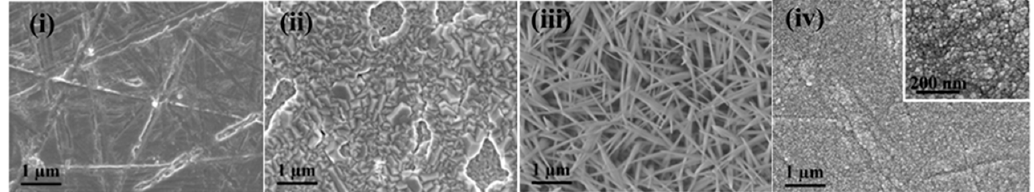
Figure 3. Performance of the IrO x /SrIrO 3 catalyst: ( A ) Chronopotentiometry measurements of 60 and 100 nm electrocatalysts, respectively, at a potential required to reach 10 mA/cm 2 per geometric area, for 30 h, in 0.5 M H 2 SO 4 electrolyte. ( B ) Tafel plots of 60 and 100 nm electrocatalysts, after 0 and 10 min, as well as 2 and 30 h of catalytic tests, compared to references in 0.5 M H 2 SO 4 electrolyte. Reproduced from [16], with permission from the American Association for the Advancement of Science, copyright 2016.